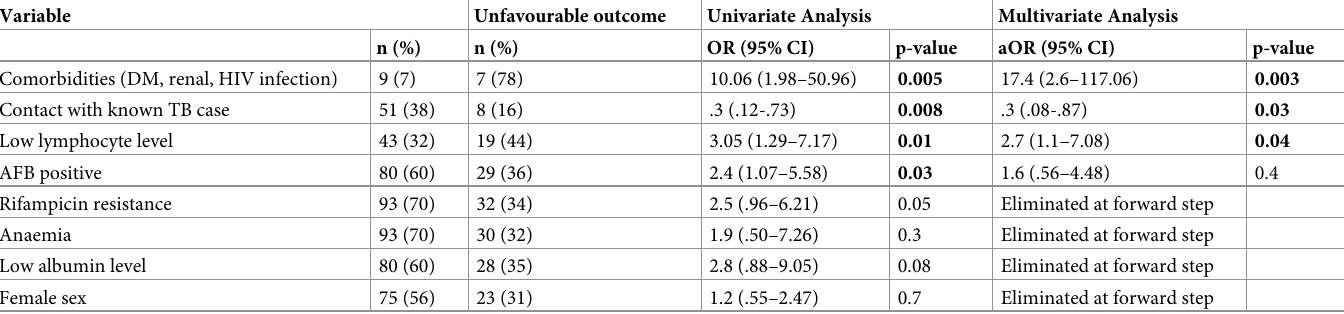
Table 4. Variables associated with unfavourable treatment outcome among drug-resistant tuberculosis cases diagnosed in the Torres Strait / Papua New Guinea border region between 2000 and 2020 (N = 133).